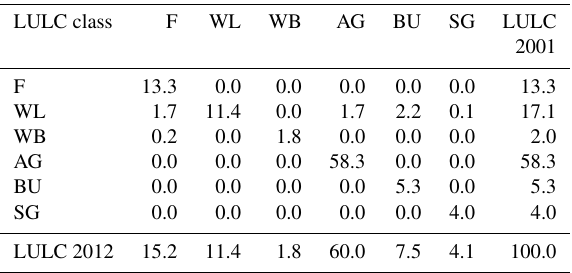
Table 6. District-scale changes in LULC in (a)